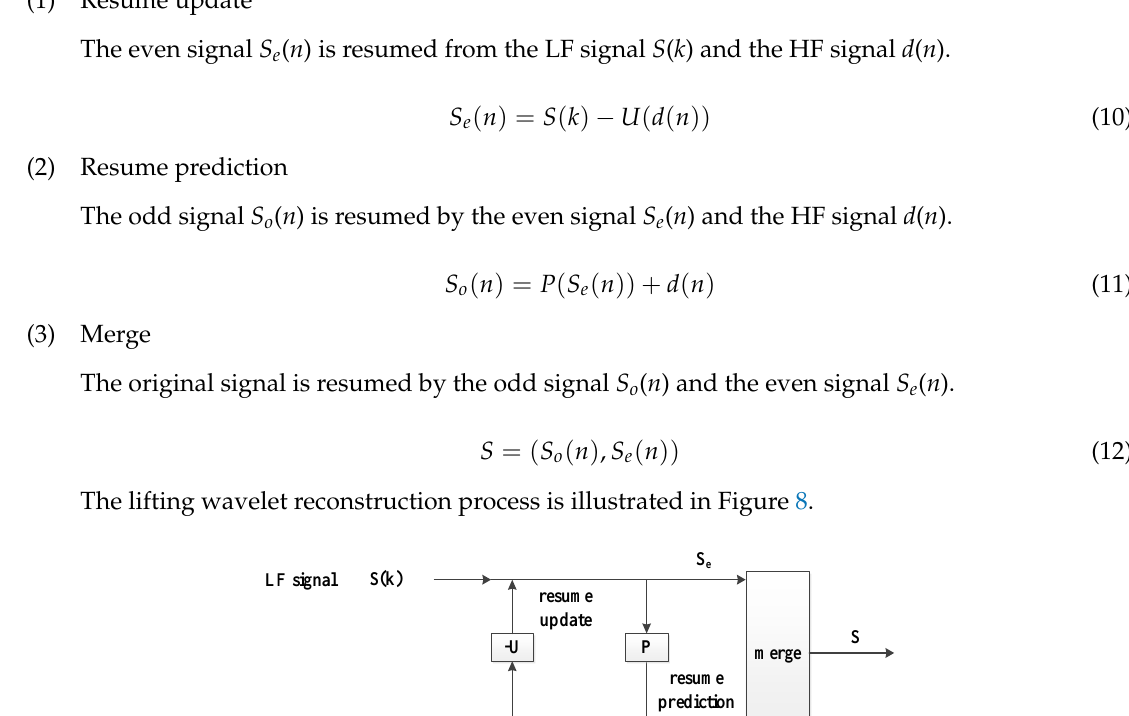
Figure 7. Diagram of lifting wavelet reconstruction.